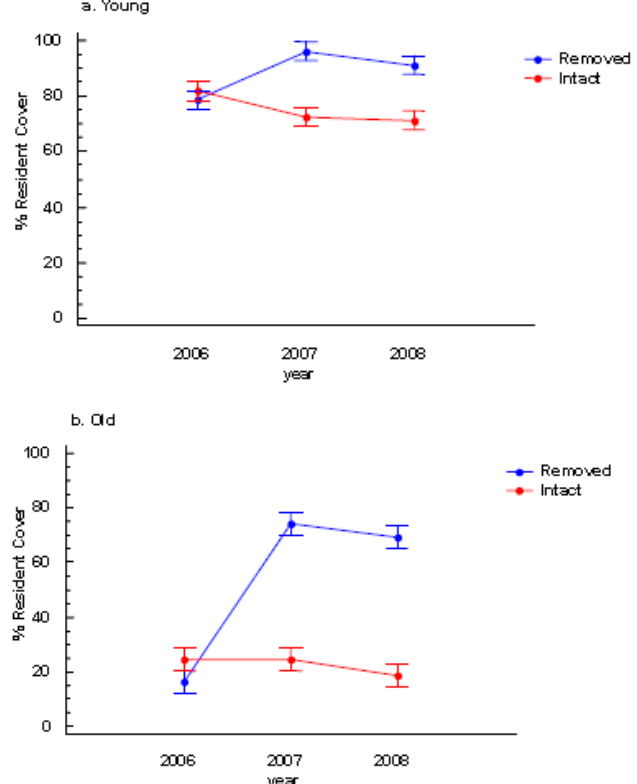
Figure 3. Resident plant species cover (%) in 2006, 2007, and 2008, before, 1, and 2 years after perennial pepperweed removal, in young (a) and old (b) strata, where perennial pepperweed was either removed or left intact. Bars are ±95% confidence